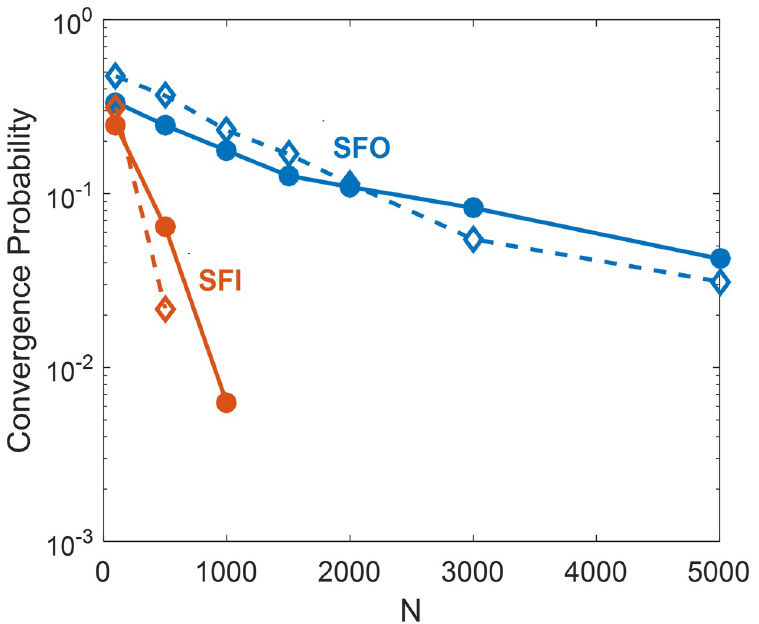
Fig 3. Convergence probability of SFO/SFI lumped-hub approximation. Probability of convergence to a Quasi Fixed Point (QFP), for SFO and SFI (blue and red filled circles respectively; same data as in Fig 1A). Their corresponding lumped-hub approximations are shown in blue and red open symbols with lumping parameter m = 4. Statistics and parameters as in Fig 1.